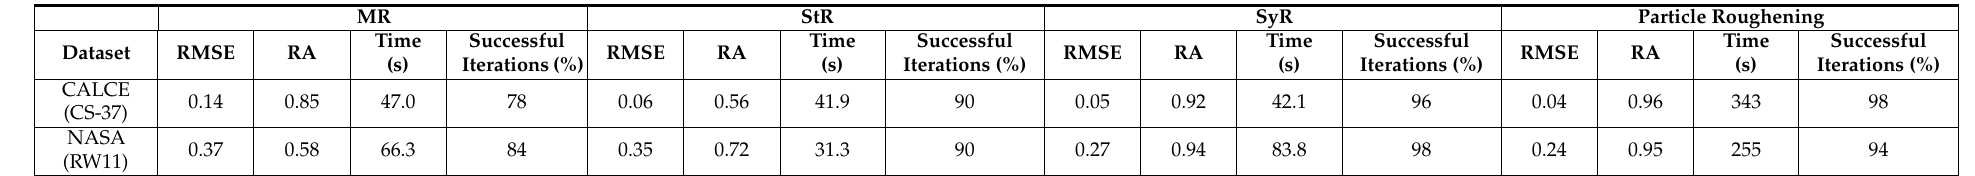
Table 2. Comparison of Performance Metrics for Different Resampling Strategies and Roughening for CALCE and NASA degradation